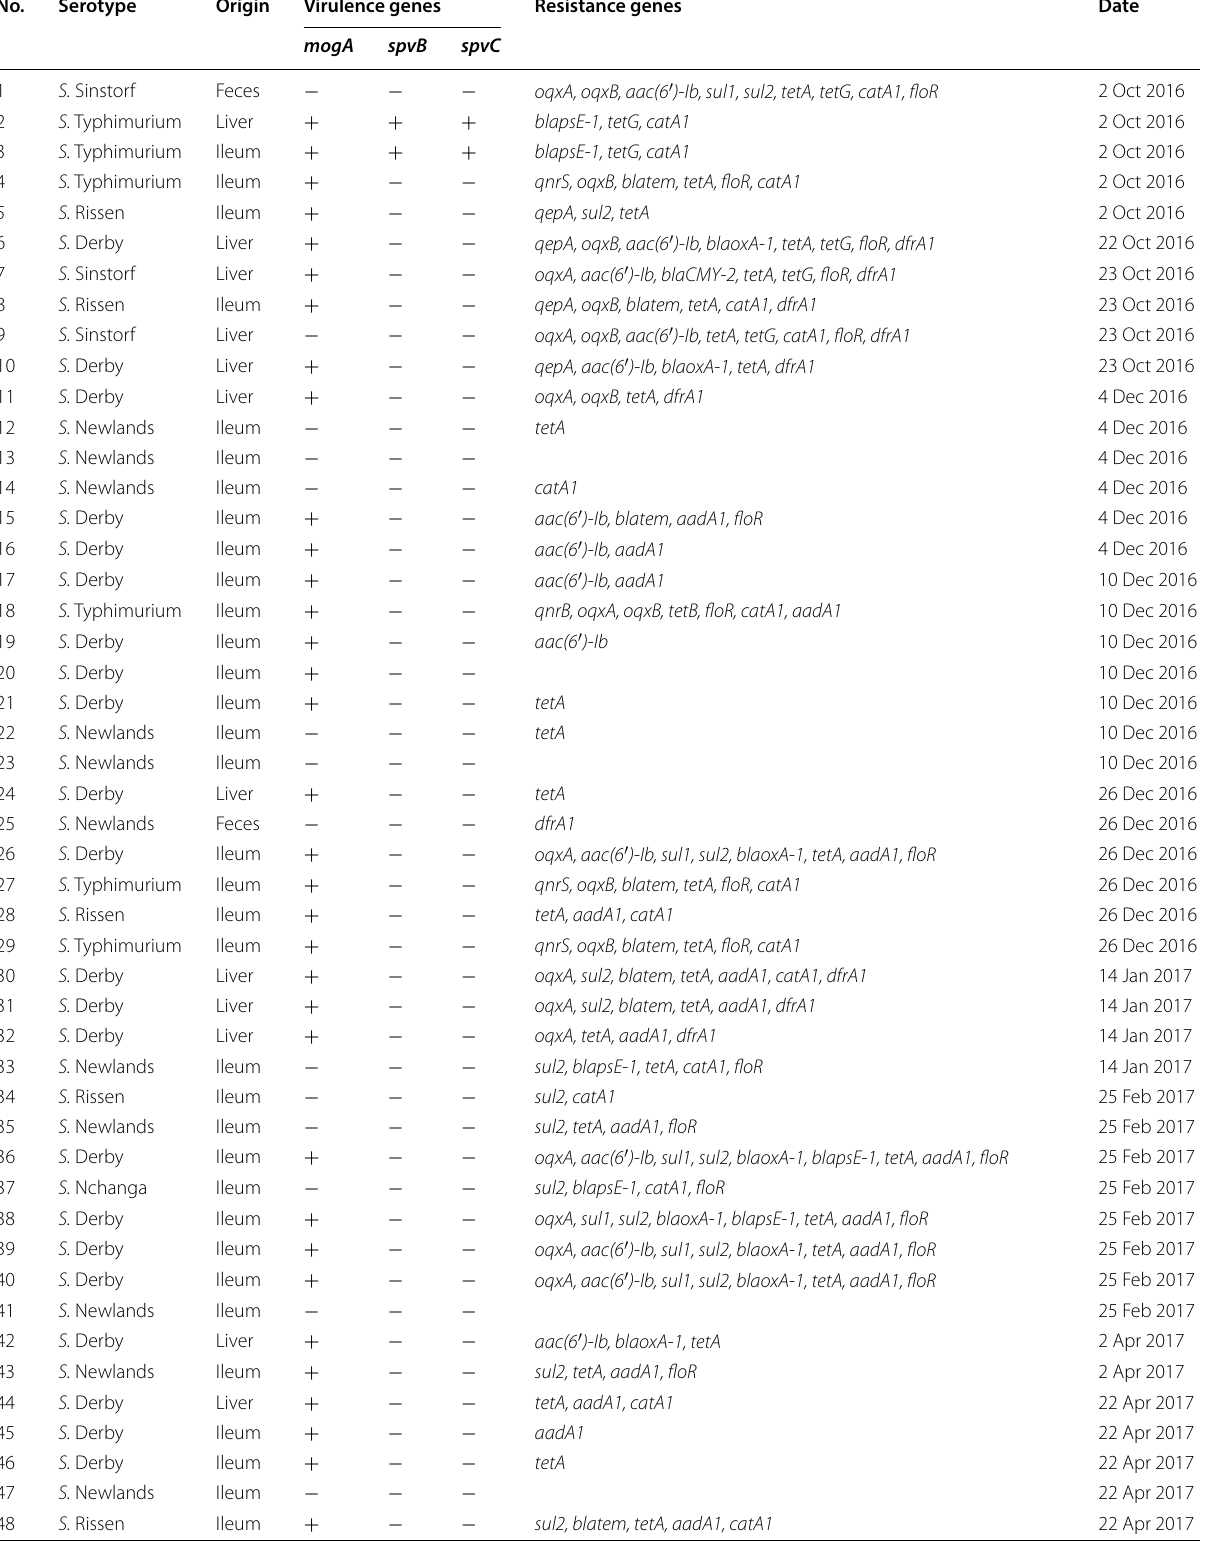
Table 2 Information of Salmonella isolated from a pig slaughterhouse in Yangzhou, China No.